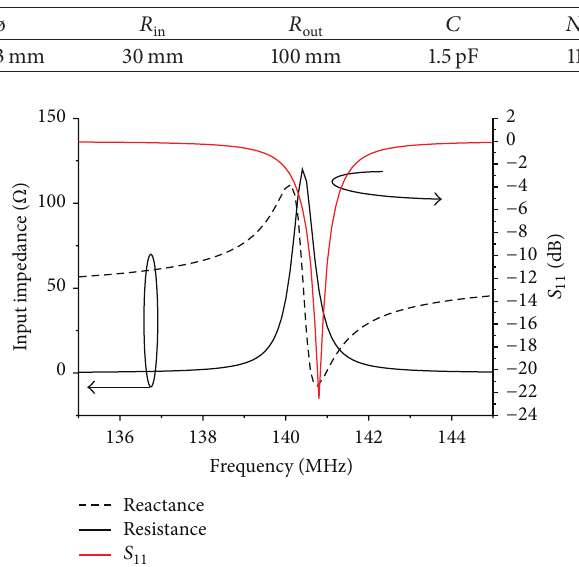
Table 1: The design parameters of the proposed antenna.